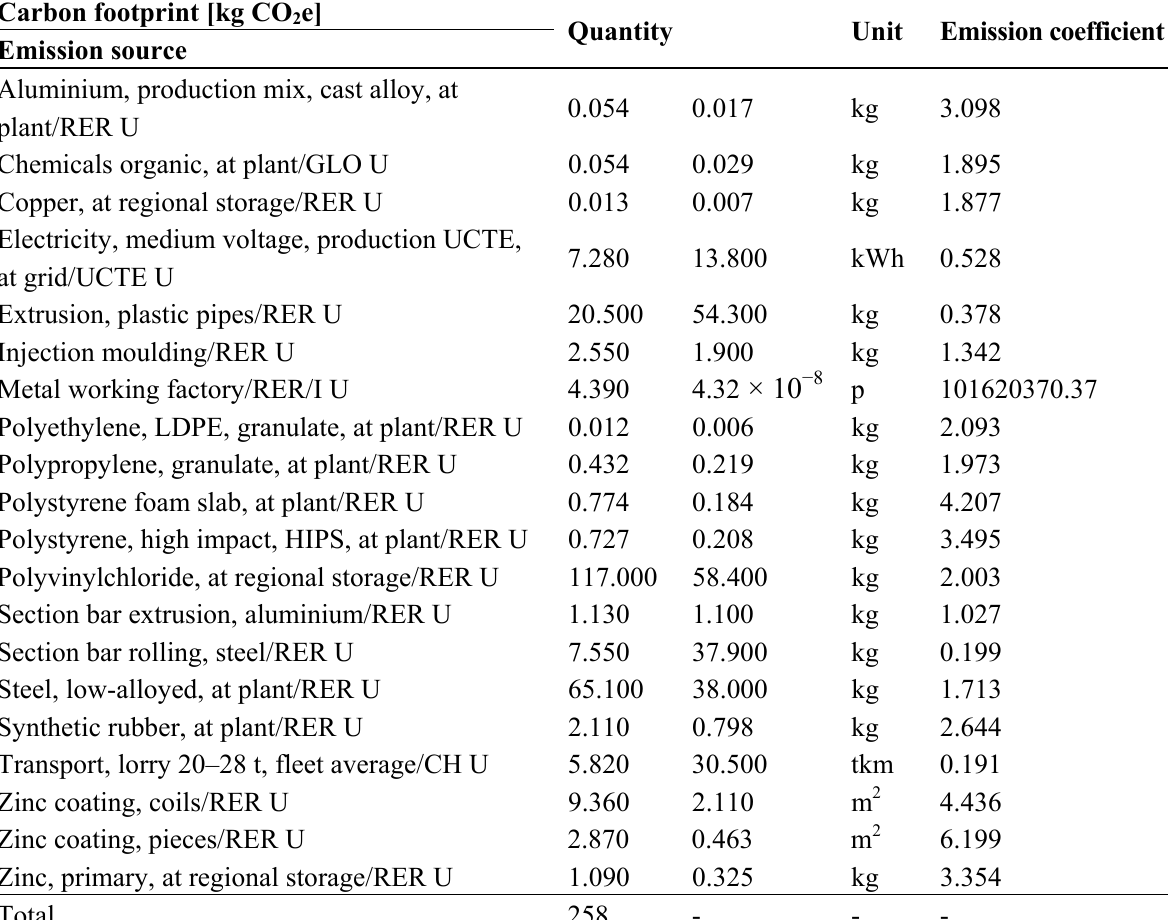
Table 4. Carbon footprint of plastic (PVC) window